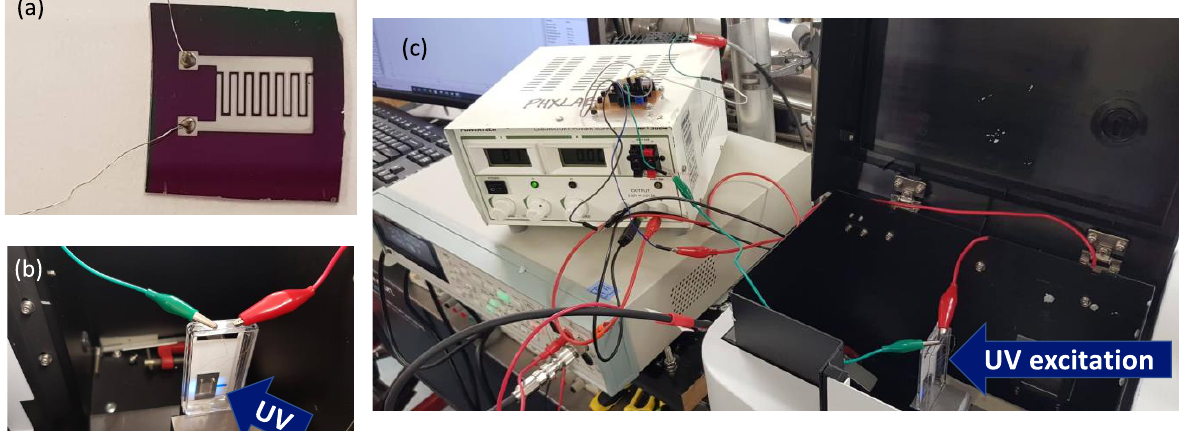
Figure 1. ( a ) Photograph of the TiO 2 thin-film photoconductive detector. ( b ) Photograph of the detector being illuminated by 260 nm UV-C radiation. ( c ) Photograph of the experimental setup used to measure the photoconductivity of the detectors.